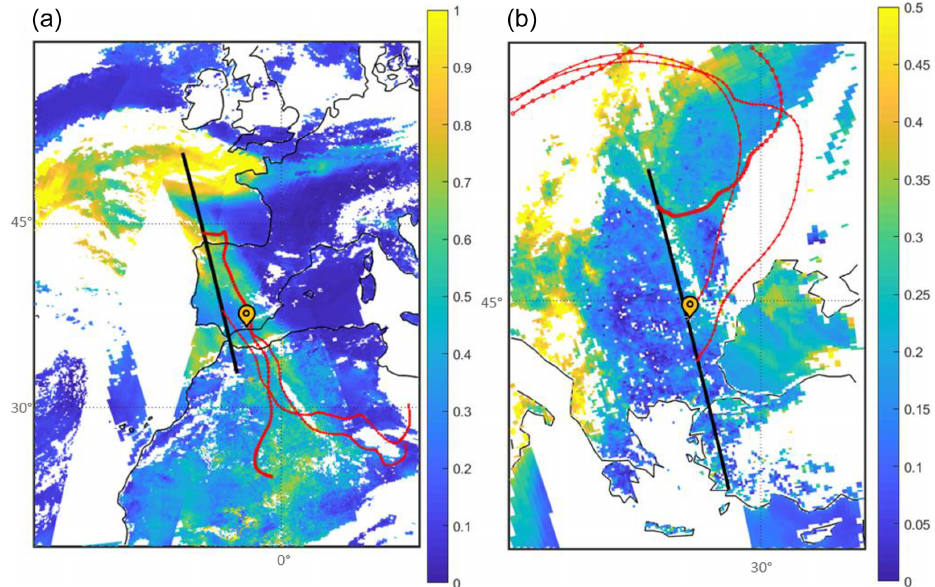
Figure 1. MODIS AOD values on 7 April 2011 (a) and 4 July 2012 (b) . The yellow pins indicate the position of Granada (a) and Bucharest (b) EARLINET stations and the black thick lines show the parts of the CALIPSO tracks considered in the current study. Air mass backward trajectories arriving at 2.5km are partly included, and are indicated by the red dotted lines. Note the different color